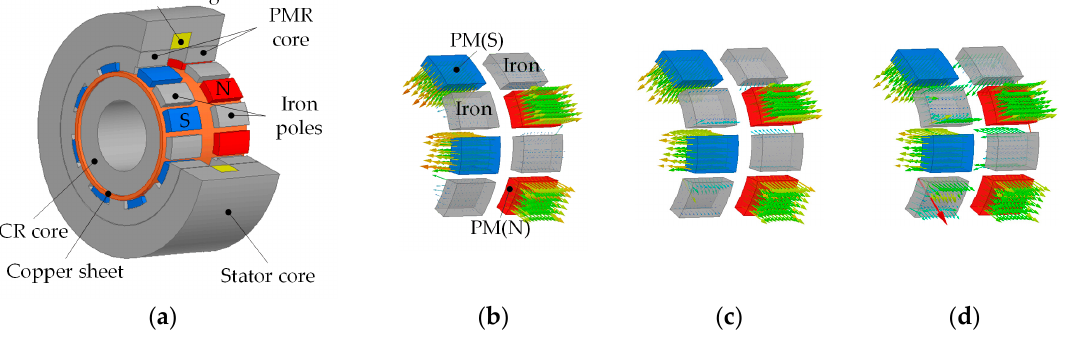
Figure 1. The magnetic field control principle of the coupling. ( a ) The topology. ( b ) I f = − 10 A. ( c ) I f = 0 A. ( d ) I f = 10 A.